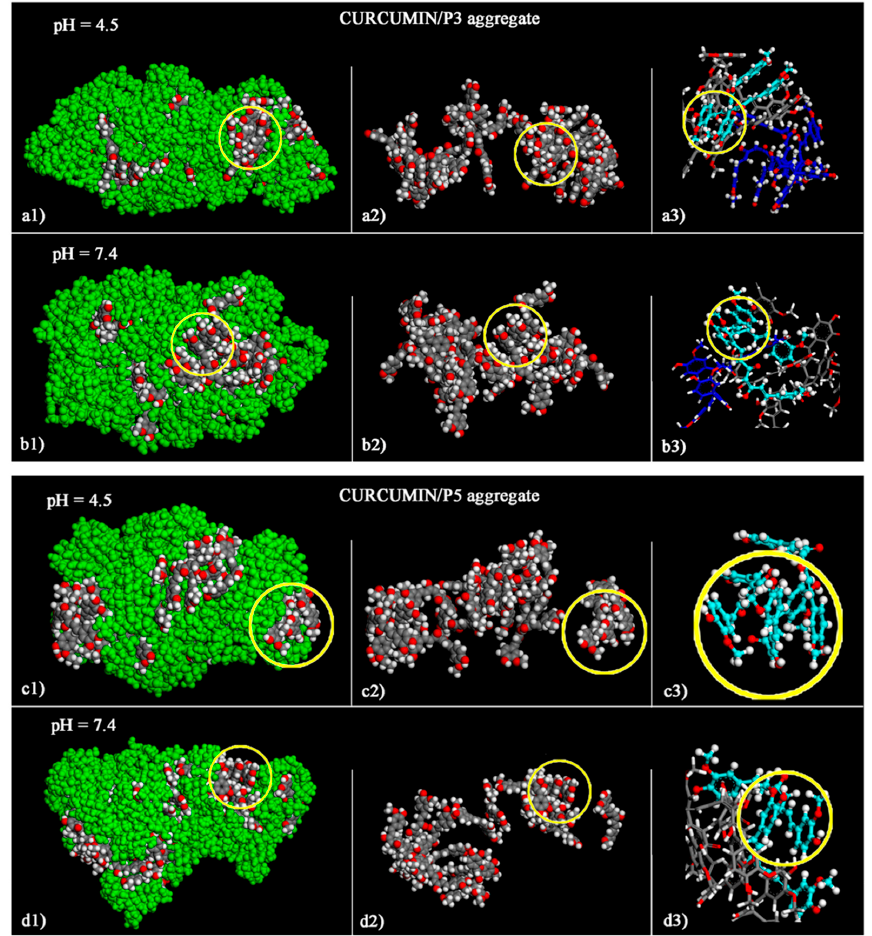
Figure 4. Optimized geometries of the curcumin/P3 aggregates at the end of MD run at pH 4.5 ( a1 – a3 ) and at pH 7.4 ( b1 – b3 ), and of the curcumin/P5 aggregates at pH 4.5 ( c1 – c3 ) and at pH 7.4 ( d1 – d3 ). On the left-hand panels ( a1 , b1 , c1 , d1 ) the atoms of P3 and P5 are all colored in green. In the same panels, the color codes of the curcumin molecules are as follows: carbon, grey; oxygen, red; hydrogen, white. For clarity, the carbon atoms of P3 and P5 are not shown in the mid panels ( a2 , b2 , c2 , d2 ). In order to provide a clearer picture of the π – π interaction among curcumin molecules, the sticks and balls structures of all aggregates are shown on the right-hand panels ( a3 , b3 , c3 , d3 ).